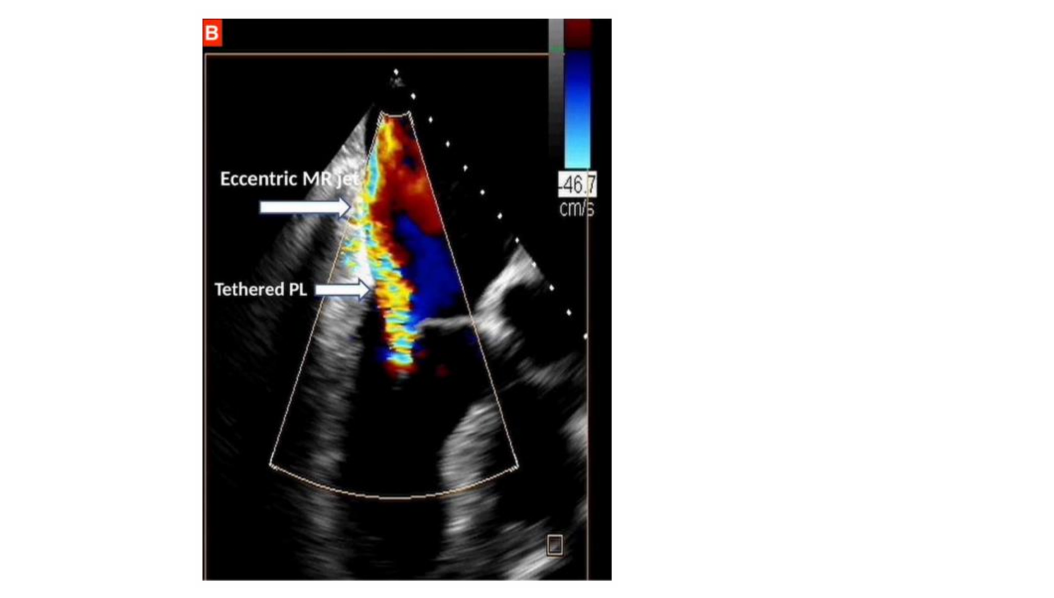
Figure 2. Transesophageal echocardiogram (TEE); ( A ): IMR with symmetric tethering characterized by central jet of regurgitation in a globally dilated left ventricle with increased mitral annulus diameter. On the left, coaptation depth (CD) may be identified as the distance between the coaptation and the annular plane; on the right, mitral valve tenting area (MVTa) is seen as the space confined between valve leaflets and annular plane. ( B ): IMR with asymmetric tethering of mitral valve leaflets, more accentuated for posterior mitral leaflet (PML), the white arrows highlight the eccentric jet of mitral regurgitation in the presence of a left ventricle which is not globally dilated.